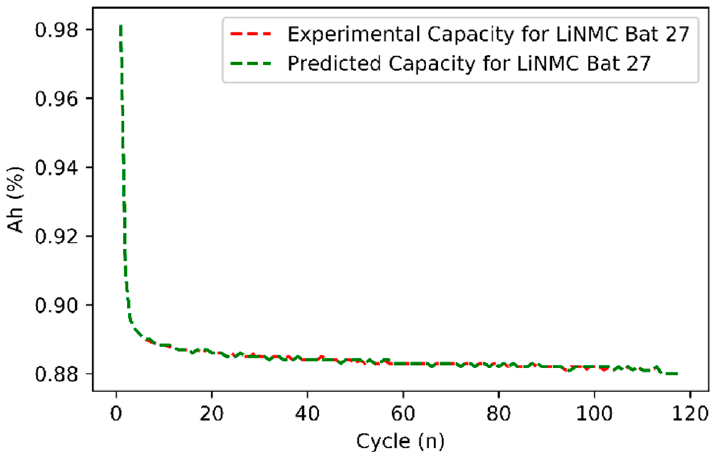
Figure 4. The capacity prediction of battery 26.